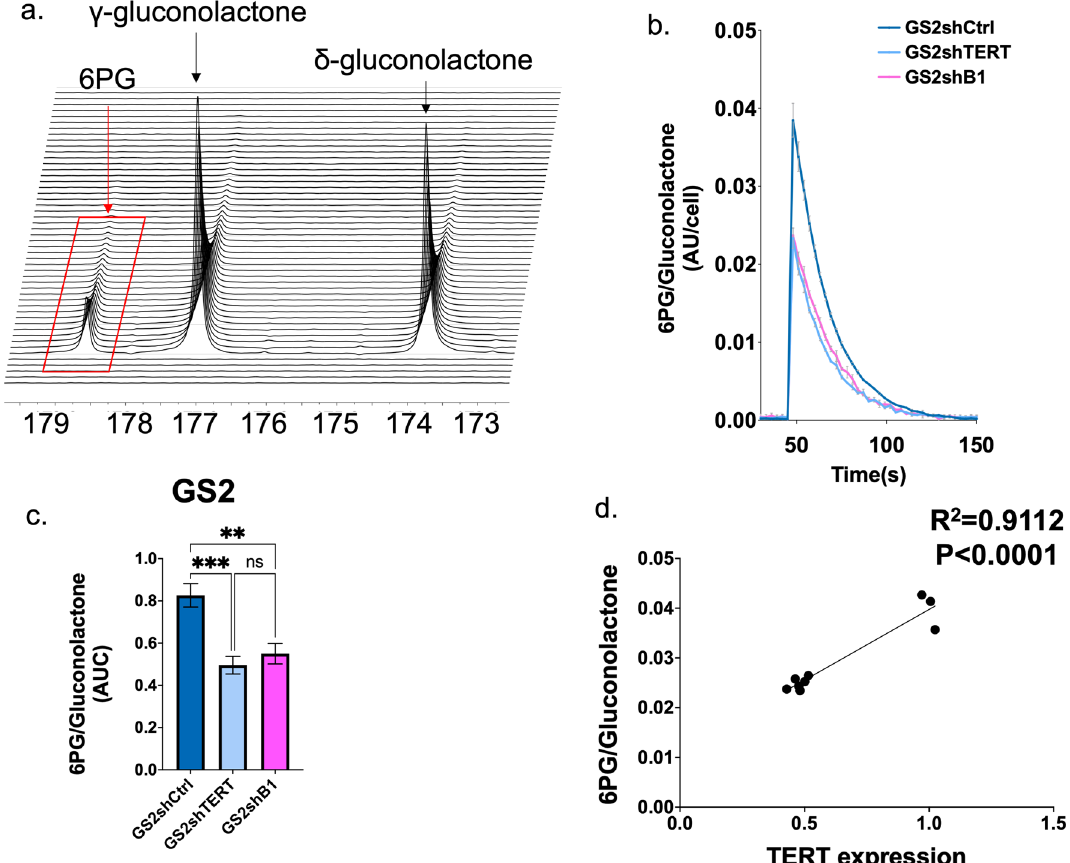
Figure 3. ( a ) Representative spectral array of 13 C spectra following injection of [1- 13 C]δ-gluconolactone